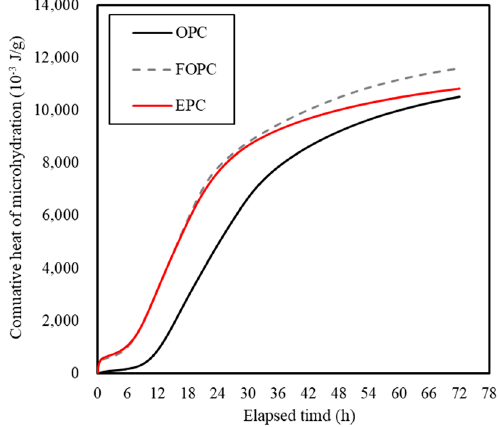
Figure 12. Cumulative heat of micro-hydration observed for OPC, FOPC, and EPC.